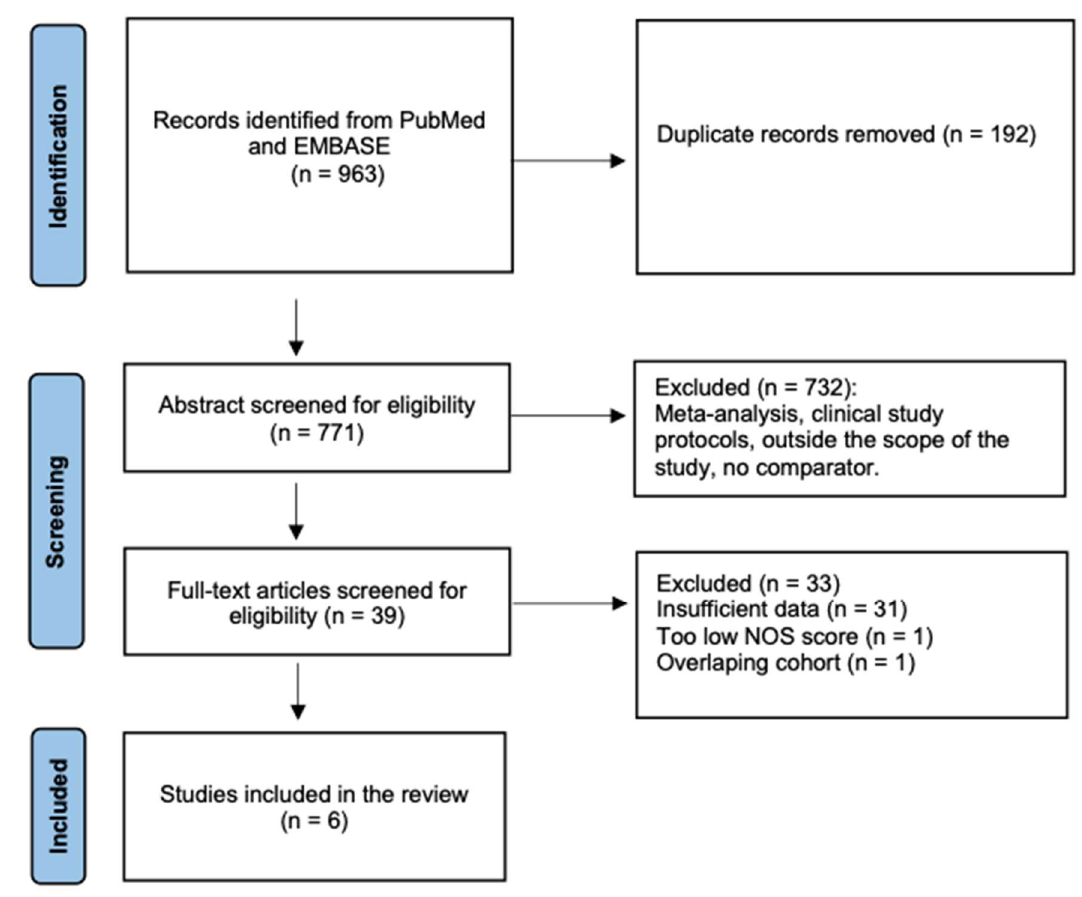
Figure 2. Flow chart of the study selection. Table 1. Characteristics of individual